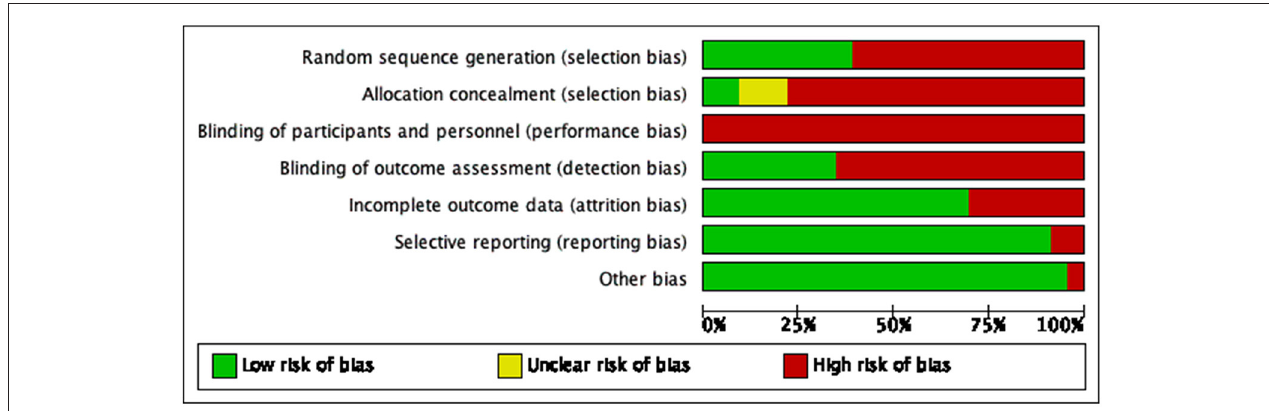
FIGURE 2 | Bias risk diagram: judgment of risk of bias expressed as a percentage of all included